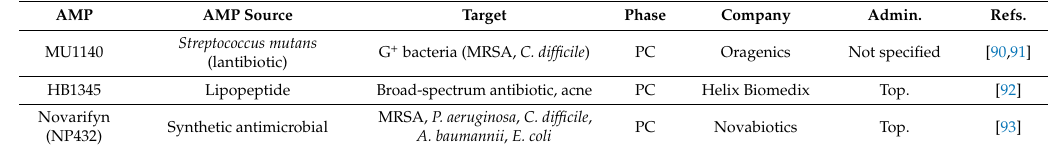
Table 2. AMPs in preclinical